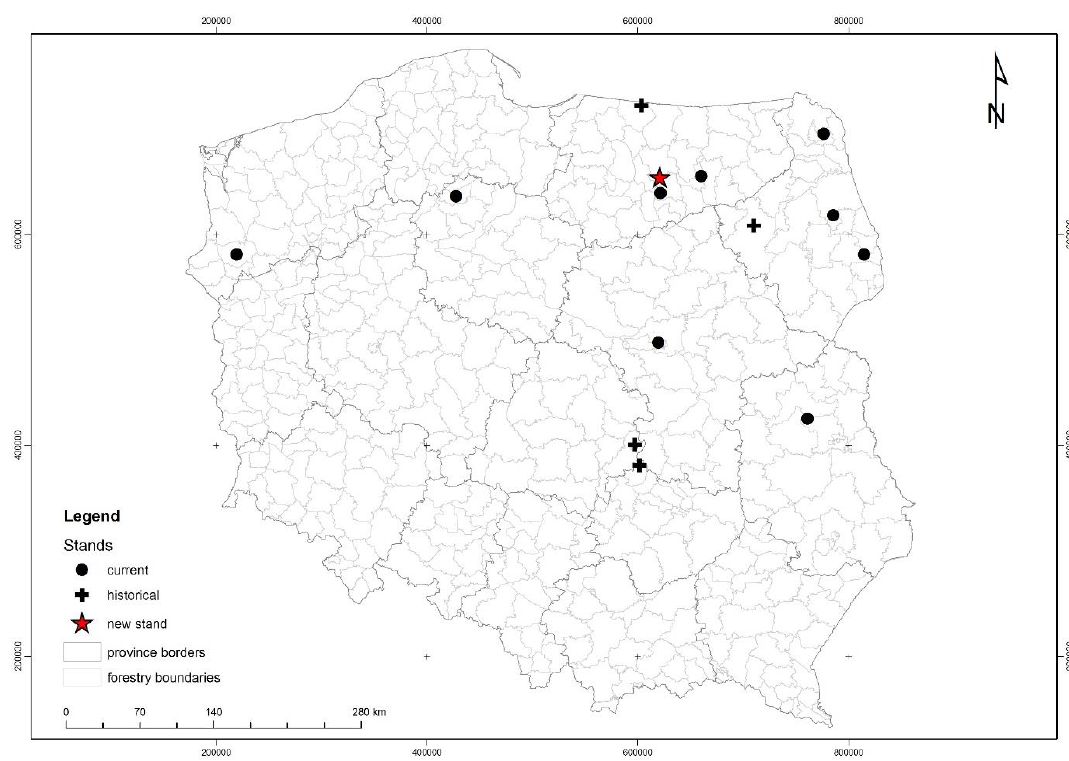
Figure 1. Distribution of the sites of Chamaedaphne calyculata in Poland [2,24,25] with the new site designated with star.